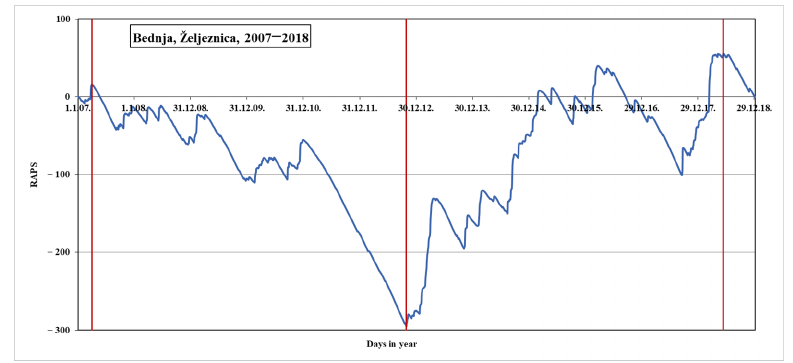
Figure 13. RAPS value on flow data from Željeznica measurement station.